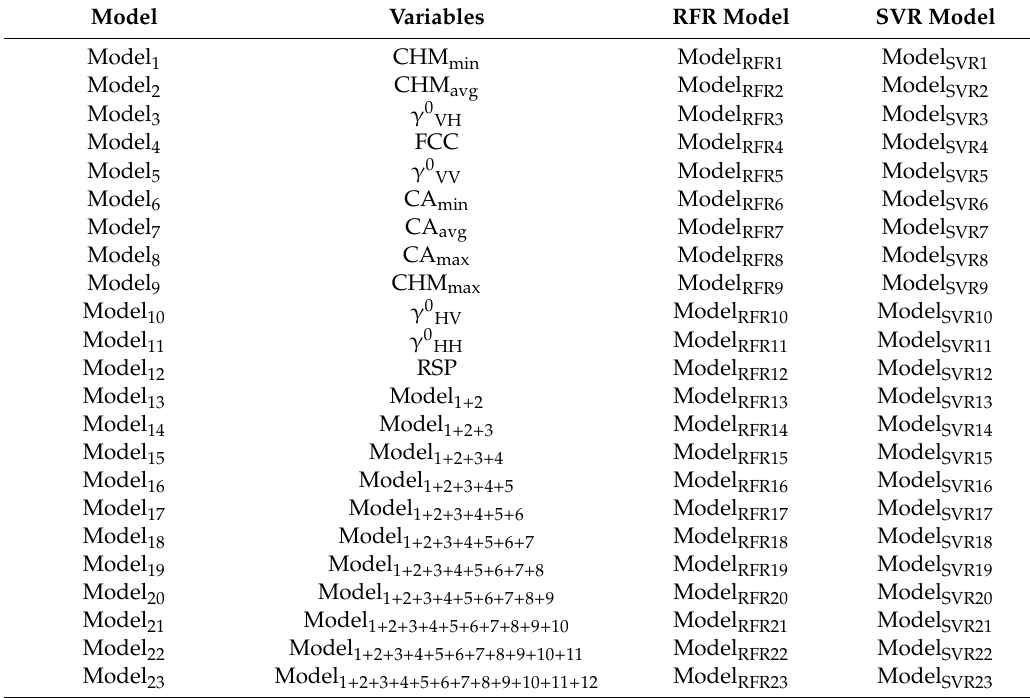
Table 1. Summary of the model combinations and its variables used. Model 1-12 is in the order from the lowest sum of residual which was checked through linear